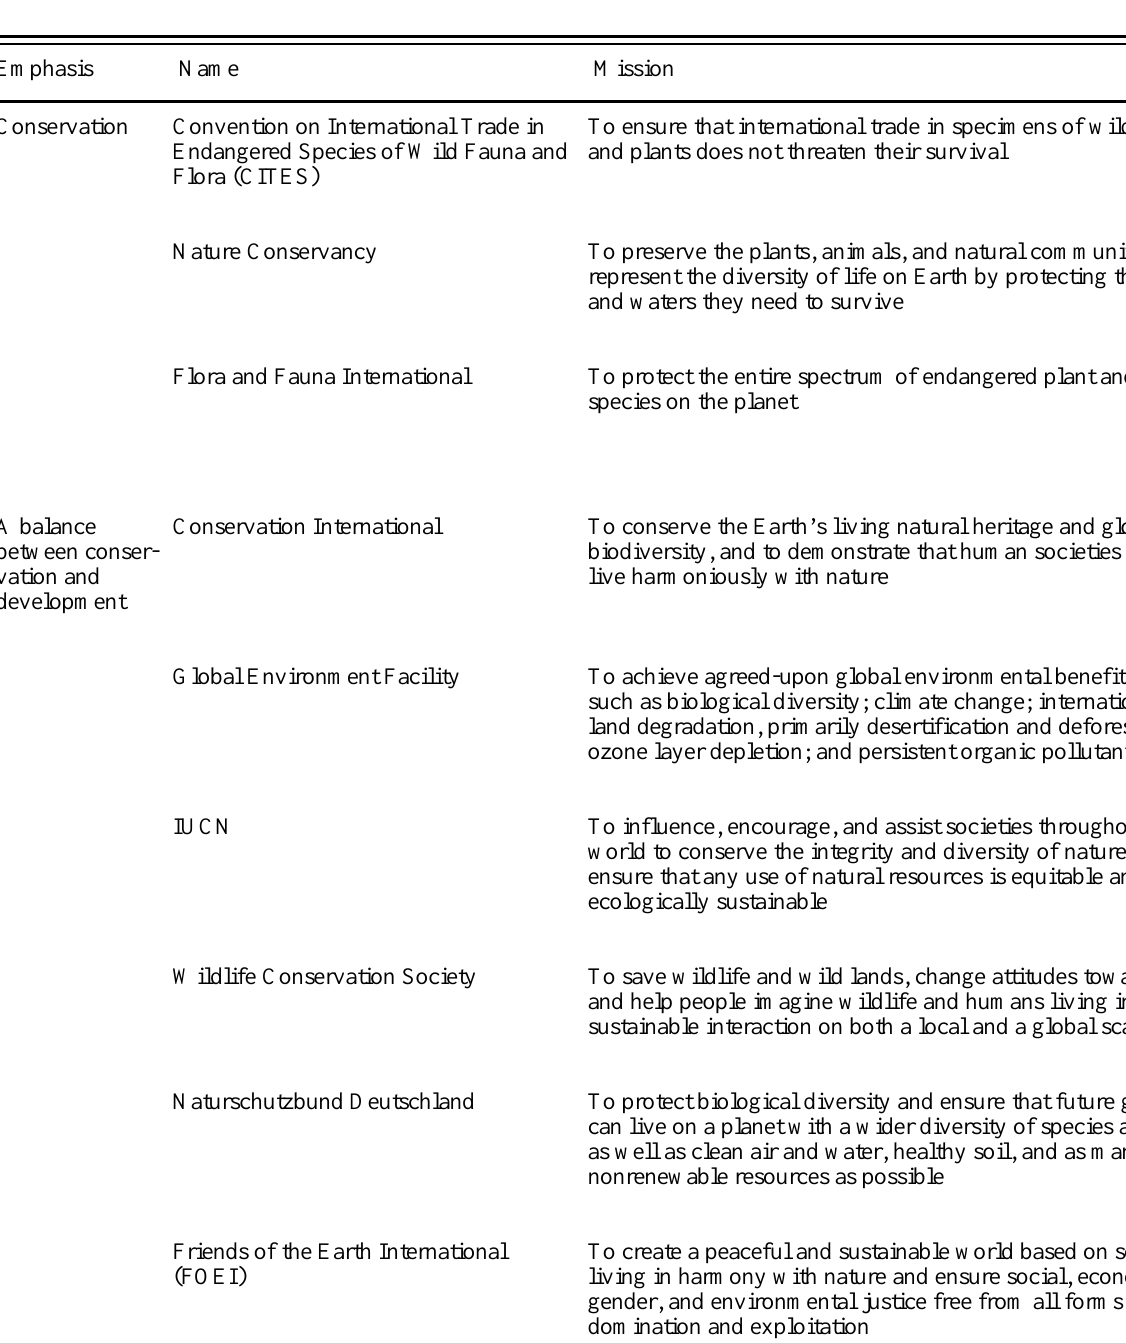
Table A-1. Objectives of a selection of international conservation and development agencies showing the extent to which the rhetoric of integrated conservation development has been